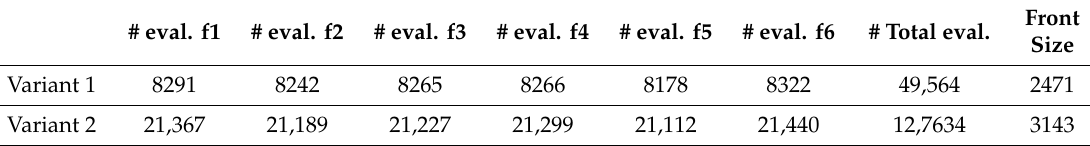
Table 1. Statistics of the objective function evaluations size of the Pareto optimal solutions for the multiobjective optimization tasks